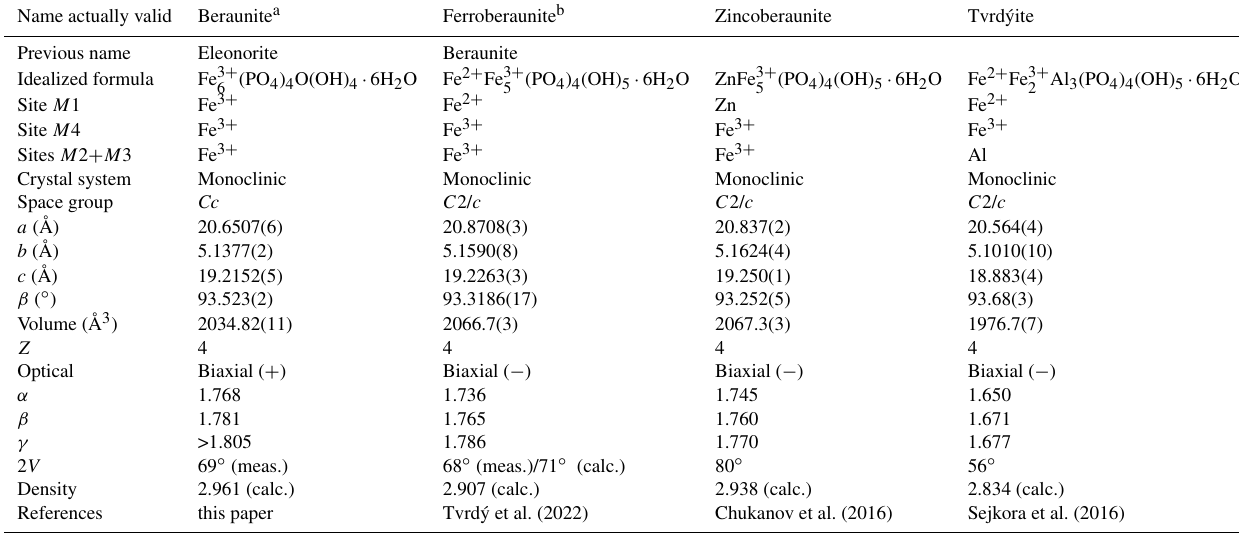
Table 10. Comparative data for beraunite and related minerals.